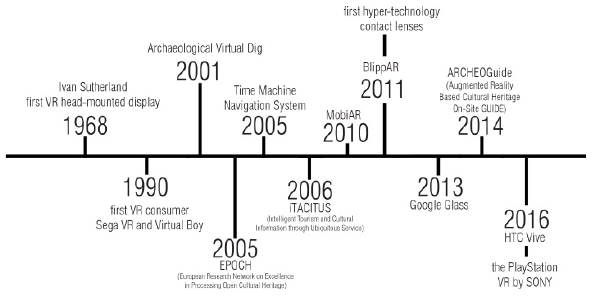
Figure 2. state of the art AR / VR